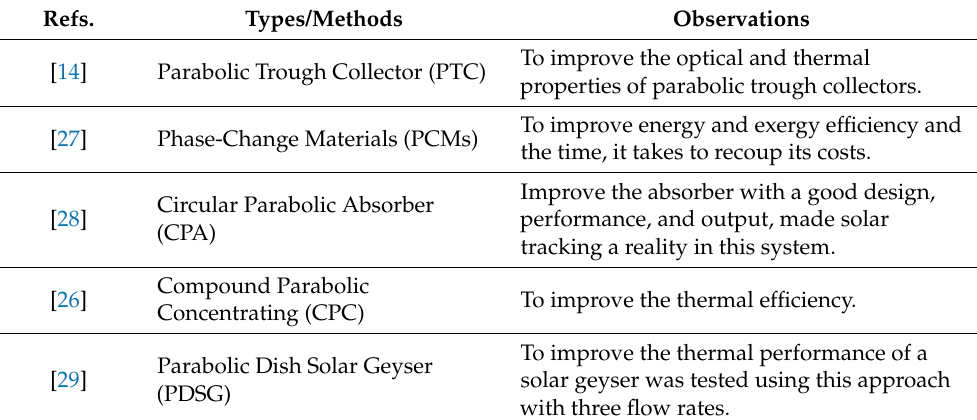
Table 1. Literature on the solar water heater.